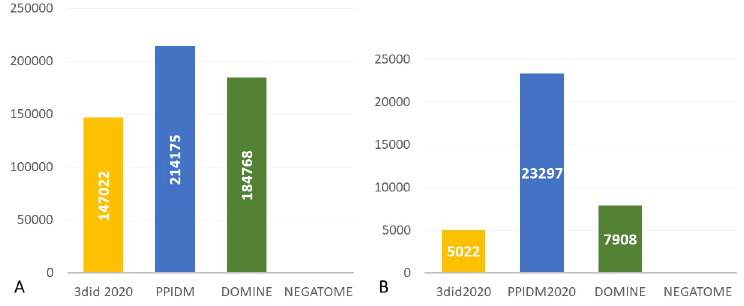
Fig 5. Coverage of human interactome derived from STRING (607, 088 PPIs). (A) Number of PPIs covered by at least one DDI; (B) Number of DDIs covering at least one PPI.